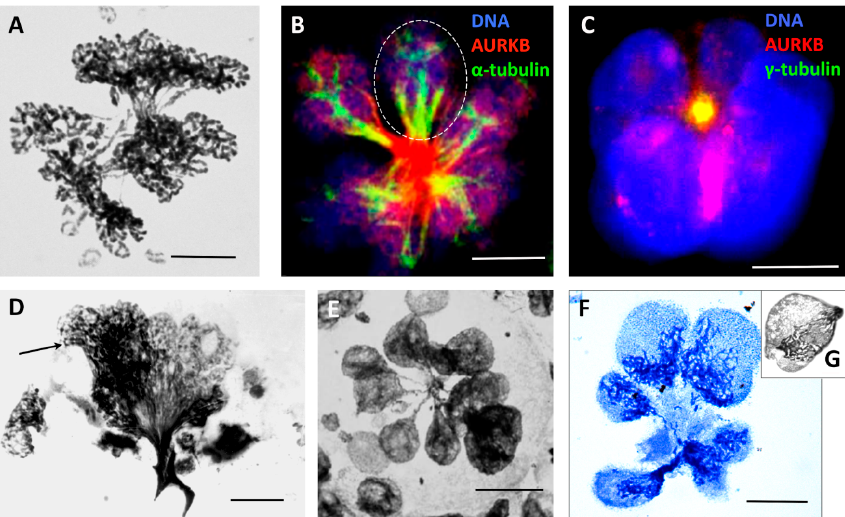
Figure 5. Multipolar metaphase-anaphase cells undergoing radial de-polyploidisation and pedogamic fusions of karyotomy products: ( A ) Multipolar mitosis figure displaying unequal partitioning of bridged sub-nuclei with connected chromosome ends separating circular chromosomes in a HeLa cell (10 Gy, Day 3). ( B ) Multipolar ana-telophase stained for AURKB (red) and a-tubulin (green). The fusion of the division mid-bodies tragged towards one centre and, in addition, the pedogamic fusion of the karyotomy products are seen as three (encircled) or one of the two spindle ‘twigs’ segregating with them, in WIL2-NS (PXT, Day 5). ( C ) A restituted radial telophase converging mid-bodies to the composed centrosome, stained for γ -tubulin and AURKB (colocalised as a yellow spot) in Namalwa cells (6 days post 10 Gy). ( D ) Low resolution EM of a giant cell that has failed radial de-polyploidisation, leading to a bouquet appearance of spindle trapped genomes partly forming sub-nuclei (on the right) and remaining looped (arrowed, on the left) (Ramos lymphoma cell, 14 days post 10 Gy) (reproduced with permission from [24]). ( E ) Multilobed telophase cell after multipolar radial reductional segregation (HeLa cells 5 days post 10 Gy) (reproduced with permission from [78]). ( F ) Radial cytotomy with unequal segregation of the genomic material in cellularised sub-cells. HeLa cells 10 Gy, Day 5 (reproduced with permission from [78]). ( G ) Secondary sub-cell with the meiosis-like ‘bouquet’ arrangement of chromosomes. HeLa cell, 15 days post 10 Gy. ( E – G ) Toluidine blue staining. Bars equal 10 µM.